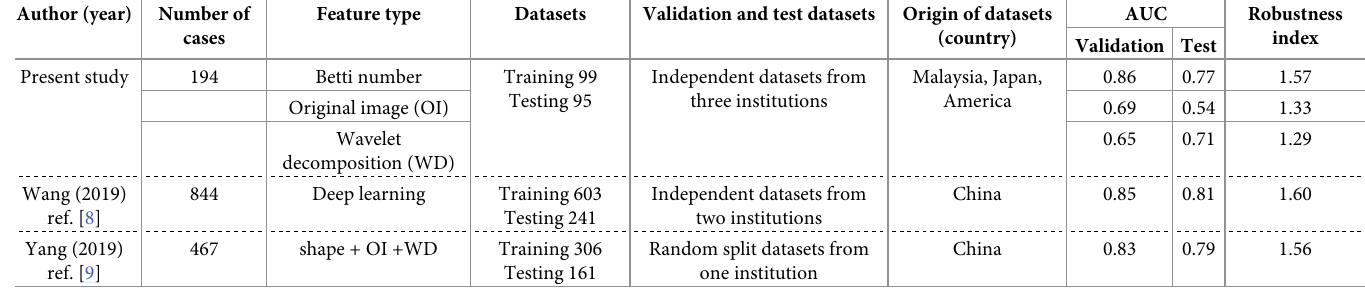
Table 5. Comparison of the results of areas under the receiver operating characteristic curves (AUCs) and robustness indices obtained from the present study and previous studies. Author